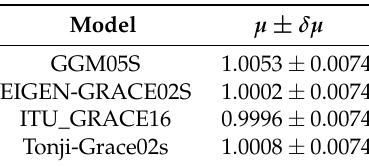
Table 4. Comparison of the results for the measurement of the relativistic Lense-Thirring precession among different models for the background gravitational field of the Earth, computed with the method of cumulative residuals. Errors appear to be equal due to rounding to the most significant digit. These results for the measured parameter µ are compatible (within their errors) with the prediction of GR for the Lense-Thirring precession: µ GR =